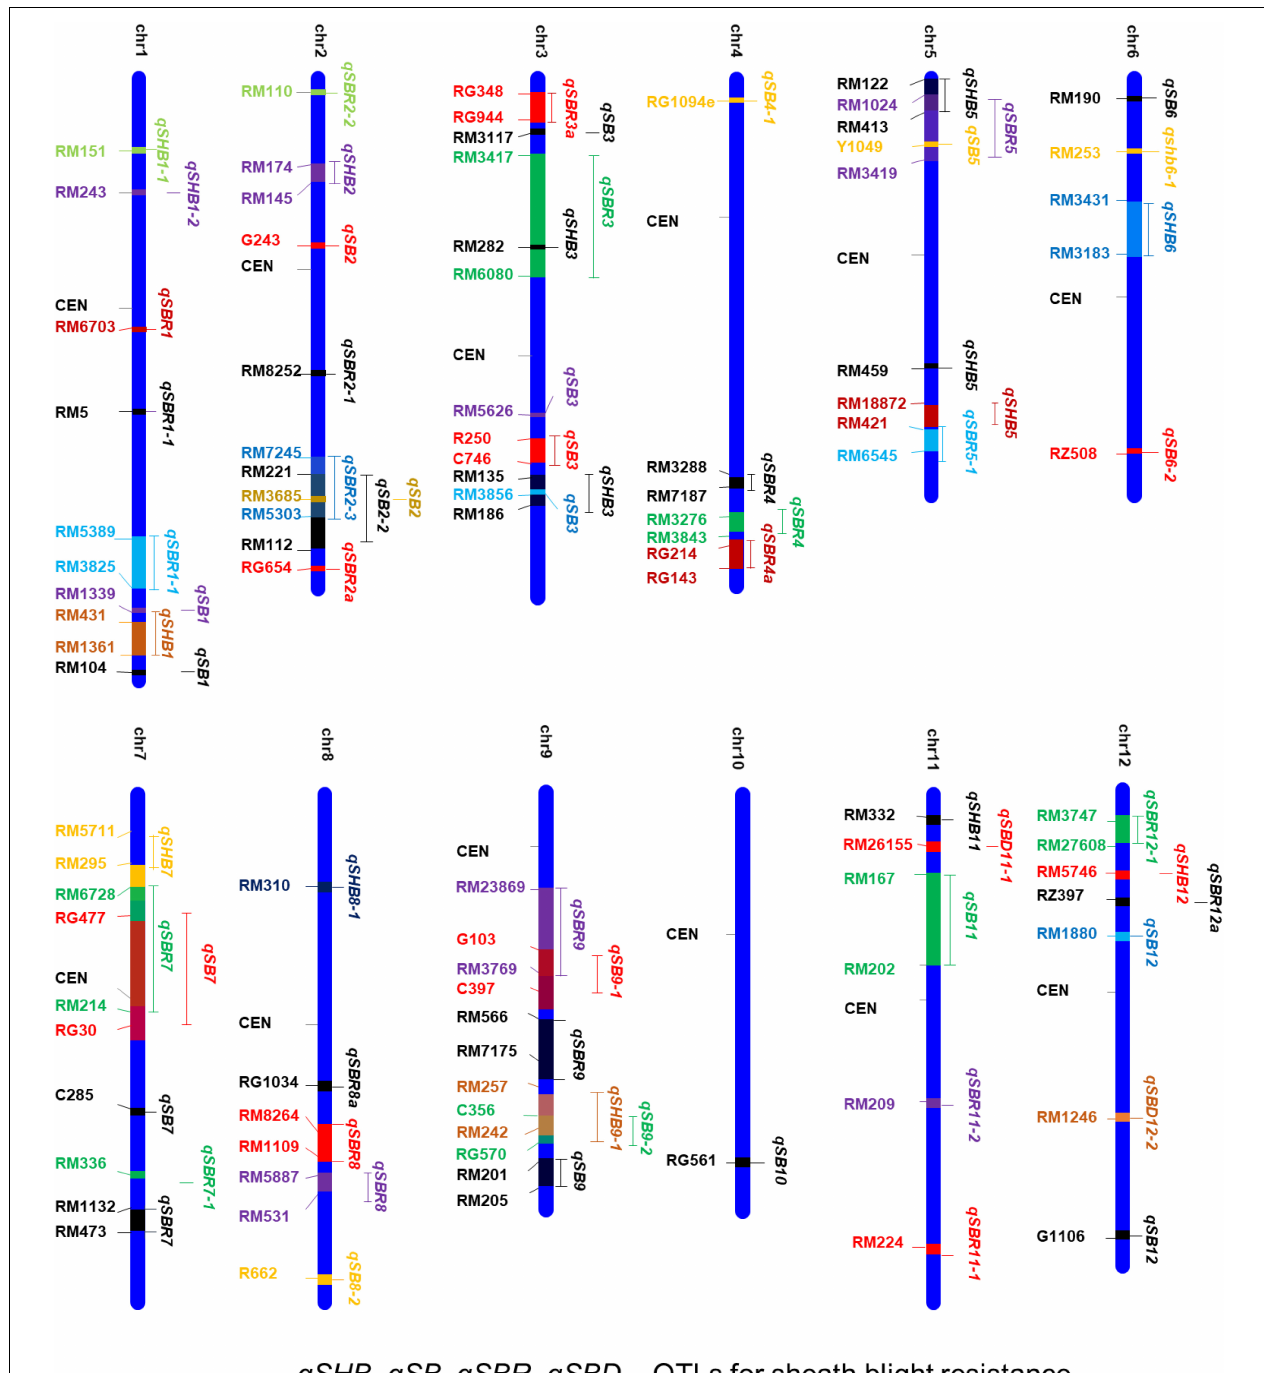
FIGURE 4 | A consolidated chromosomal map showing the QTLs mapped and the markers linked to sheath blight resistance in rice. qSHB, qSB, qSBR, and qSBD indicate the quantitative trait loci for sheath blight disease resistance.